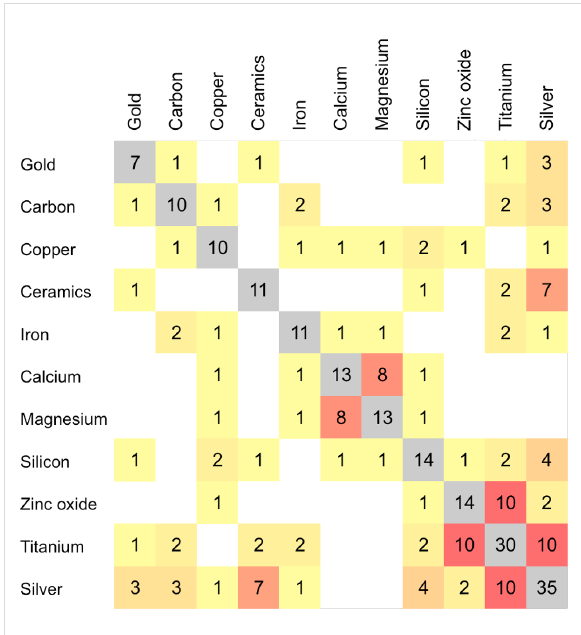
Figure 4: Major nanomaterial composition pairs in consumer products. Carbonaceous nanomaterials (carbon black, carbon nanotubes, fullerene, and graphene) were combined into the same category (carbon). Grey boxes in the diagonal represent the total times each nanomaterial composition has been listed with other compositions in the same